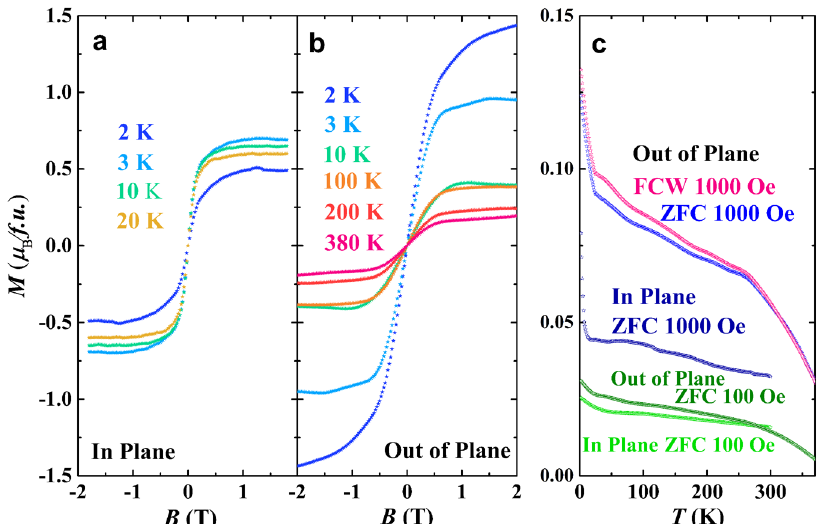
Fig. 4 Magnetic properties of SCMO thin fi lm S 5 . a , b The magnetic hysteresis curves of SCMO at various temperatures. c The temperature- dependent magnetization curves range from 2 K to 300 K, with 100 Oe and 1000 Oe applied fi eld in ZFC and FC process,